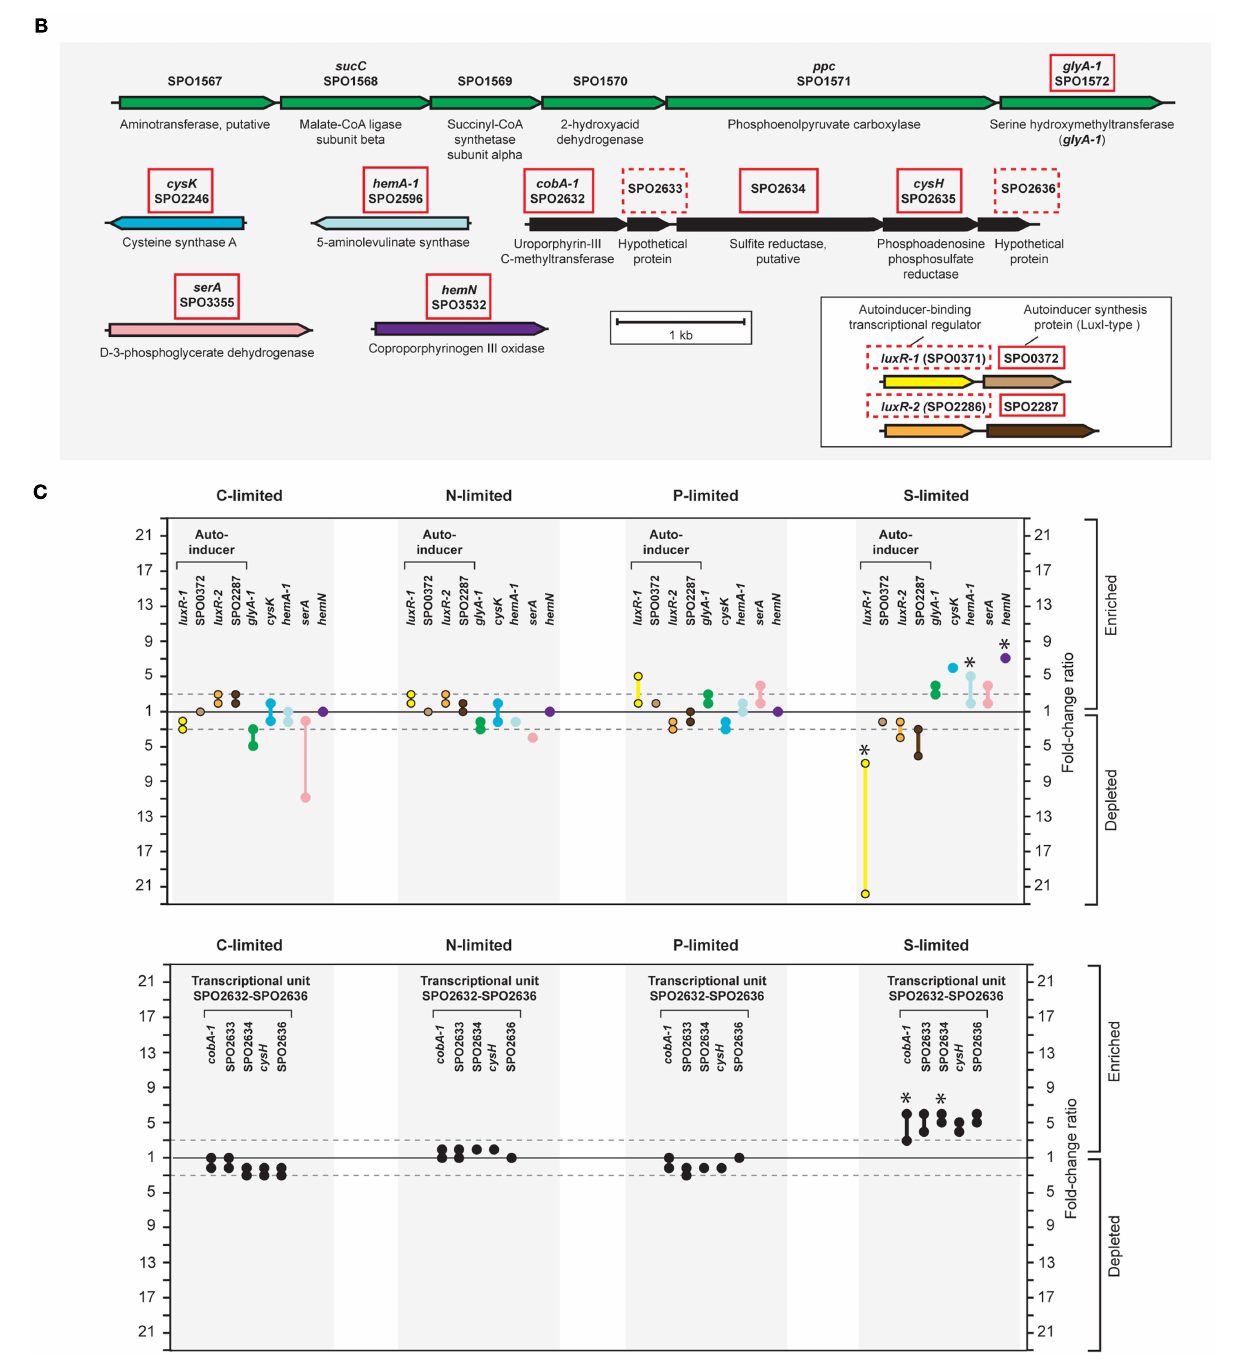
sets of orthologous LuxR–LuxI-type proteins are boxed in (B) . Symbols for autoinducer-binding or synthesis genes (yellow, orange, brown) are bordered in black in (C) . *Transcriptional change is significant ( ≥ 3-fold, all limitation-to-excess pairwise comparisons). Abbreviations in (A) as follows: THF, tetrahydrofolate; 5-mthglu, 5-methyltetrahydropteroyltri-l-glutamate; thglu,